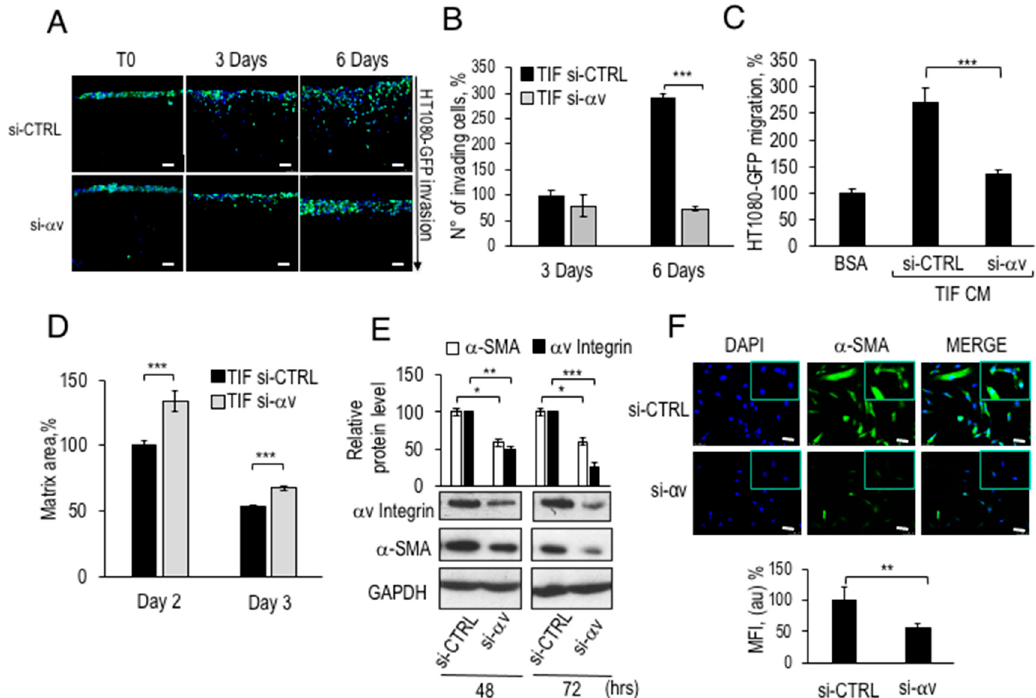
Figure 6. Decreased pro-invasive ability, matrix contraction capacity, and α -SMA protein levels in α v-silenced TIF fibroblasts. ( A ) Organotypic assay conducted with 5 × 10 4 TIF fibroblasts, transfected with siRNA CTRL or si- α v, combined with a collagen I solution. 1 × 10 5 HT1080-GFP cells were seeded on top of these matrices, incubated for 2 days (T0) and let to invade for 3 or 6 days. Matrices were processed as described in the legend to Figure 3. Scale bar 50 µ m. ( B ) The number of invading HT1080-GFP cells in ( A ) was quantified, normalized to T0 and reported as percentage of si-CTRL fibroblasts after 3 days, considered as 100%. ( C ) 5 × 10 4 TIF fibroblasts, transfected with si-CTRL or si- α v, were grown for 48 h in DMEM-10% FBS and serum-starved for 24 h. CM were collected and employed as chemoattractants for HT1080-GFP in Boyden chamber assays as described in the legend of Figure 3D. ( D ) Contraction assay carried out with 5 × 10 4 TIF fibroblasts transfected with siRNA CTRL or siRNA to integrin α v and, after 24 h, mixed with the collagen I solution. The reduction of matrix diameter was monitored for 3 days. The area of matrices with TIF fibroblasts transfected with si-CTRL at day 2 was taken as 100%. ( E ) Western blot of total lysates from fibroblasts transfected with siRNA CTRL or siRNA to α v integrin were collected and subjected to quantitation of α -SMA and α v protein levels using GAPDH as a reference. The whole blot image can be found in Figure S8. ( F ) 2 × 10 4 fibroblasts were seeded in DMEM-10% FBS on cover slips in 6 well plates for 24 h and silenced for integrin α v expression by RNA interference. After 72 h, cells were fixed and stained with DAPI or anti- α -SMA antibody by immunofluorescence (20 × magnification and 63 × in the inset). Scale bar 50 µ m. The MFI following staining with anti- α -SMA antibody was quantified and reported as indicated in the legend to Figure 5D. * p < 0.05; ** p < 0.005; *** p < 0.001, Student’s t